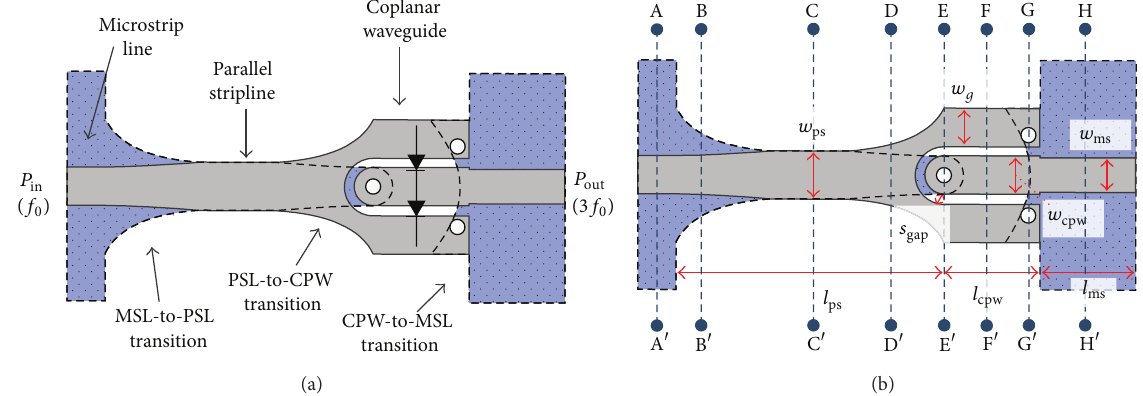
Figure 4: Proposed frequency tripler (Type B): (a) structure; (b) transition.